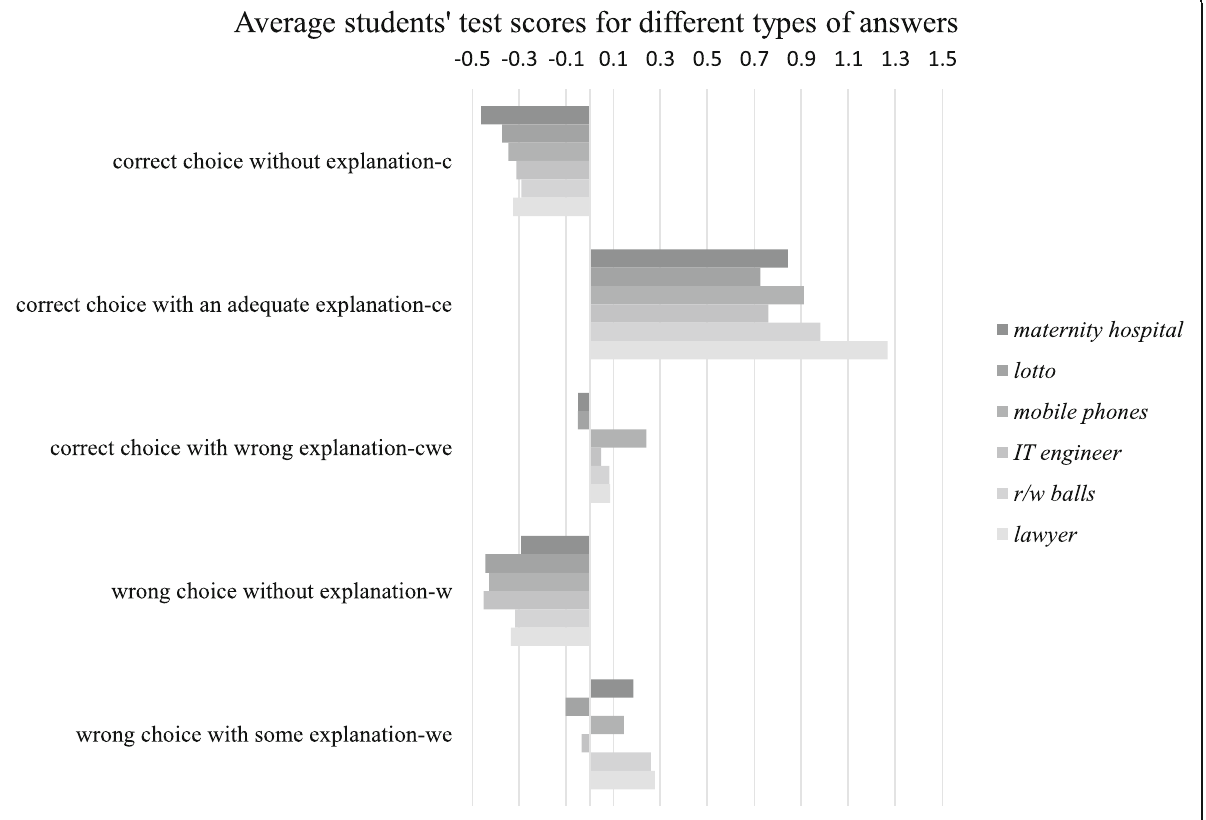
Fig. 3 Average students ’ test score for different types of